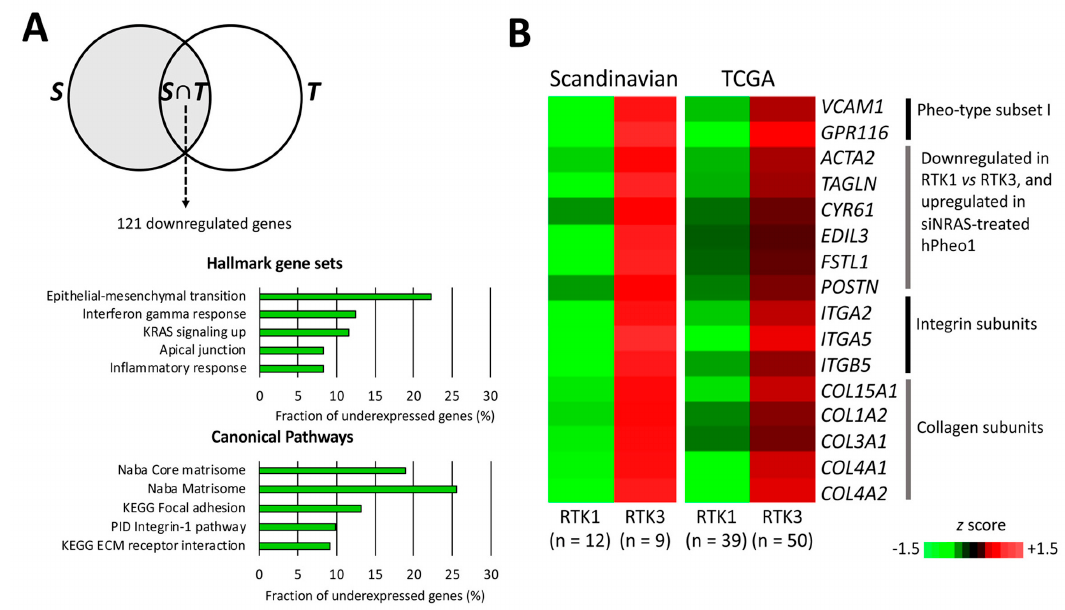
Figure 7. Comparison of RTK1 and RTK3 subclusters. ( A ) Venn diagram (upper panel) illustrating the analysis workflow for patient cohort data. RTK1 tumours were compared to RTK3 tumours in the Scandinavian cohort S (grey area). Expression values of significantly under-expressed genes were extracted from the TCGA cohort and the RTK1 and RTK3 clusters were compared (student’s T -test p < 0.05 with correction ad modum Bonferroni), yielding the intersection of S and differentially expressed genes in the TCGA cohort ( T ), i.e., S ∩ T , which contained 121 genes significantly downregulated in RTK1 lesions from both cohorts. In the lower panels, the top five significantly under-represented gene sets in RTK1 from the Hallmark (middle panel) and Canonical Pathways set collections (lower panel) are shown. ( B ) Expression of genes downregulated in the RTK1 cluster of both cohorts and either belonging to Pheo-type subset I, or being upregulated by siNRAS treatment of hPheo1 cells, or encoding integrin and collagen subunits; expressed as the mean z score for each group.